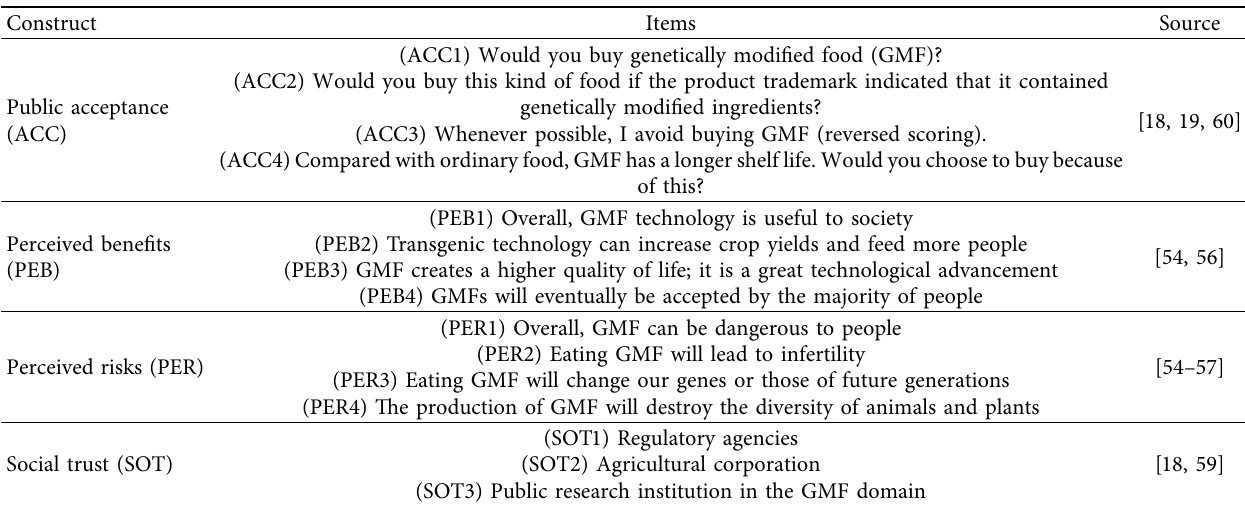
Table 3: Measures used in the